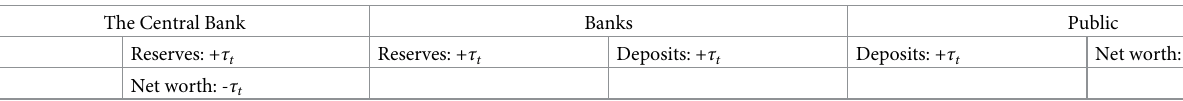
Table 3. Helicopter money / lump-sum tax. The Central Bank